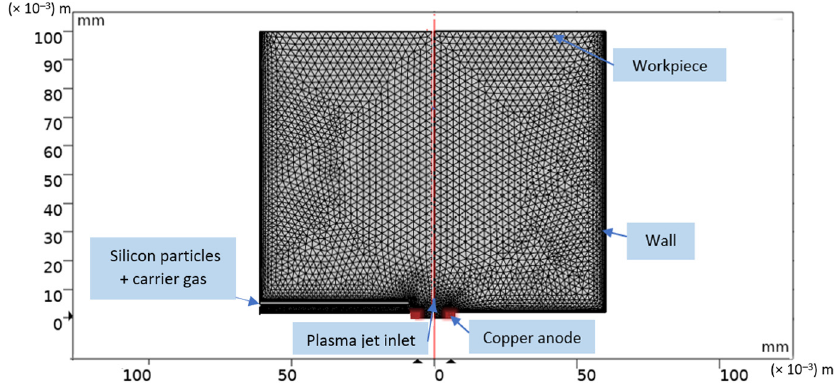
Figure 5. Computational domain of reactor chamber.